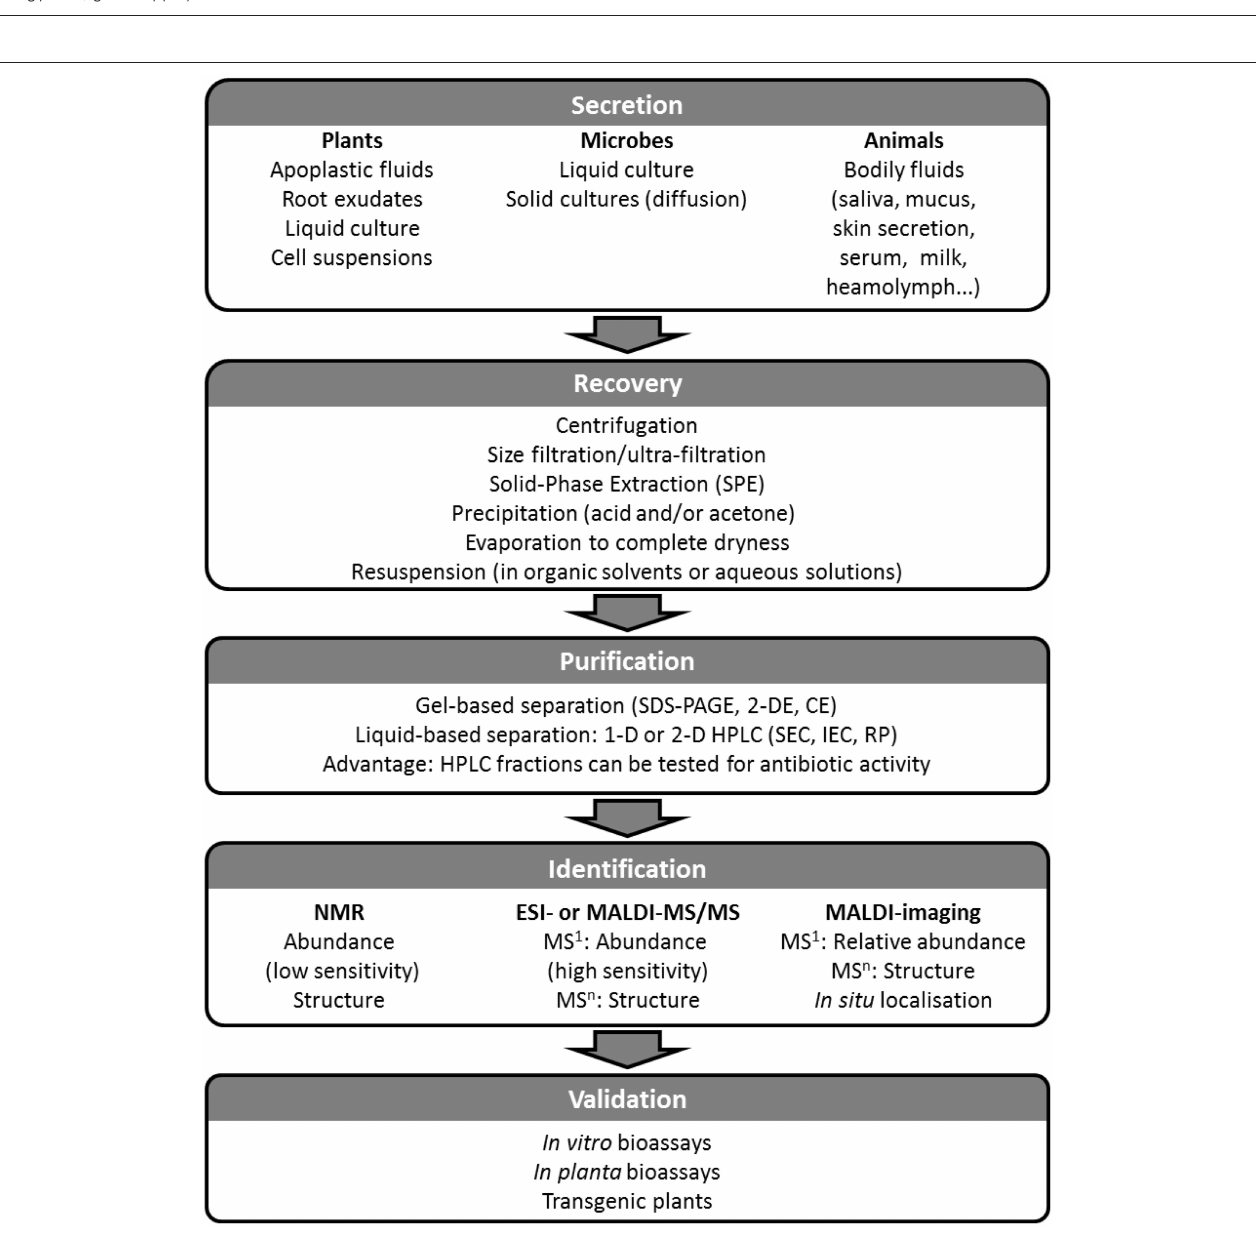
FIGURE 2 | Diagram for the identification and validation of AMPs bearing biocontrol potential in plant immunity. Secreted AMPs can be recovered from any inter- or extra-cellular space and from any organism. Being dilute, secreted AMPs will need to be concentrated using one or a combination of the methods